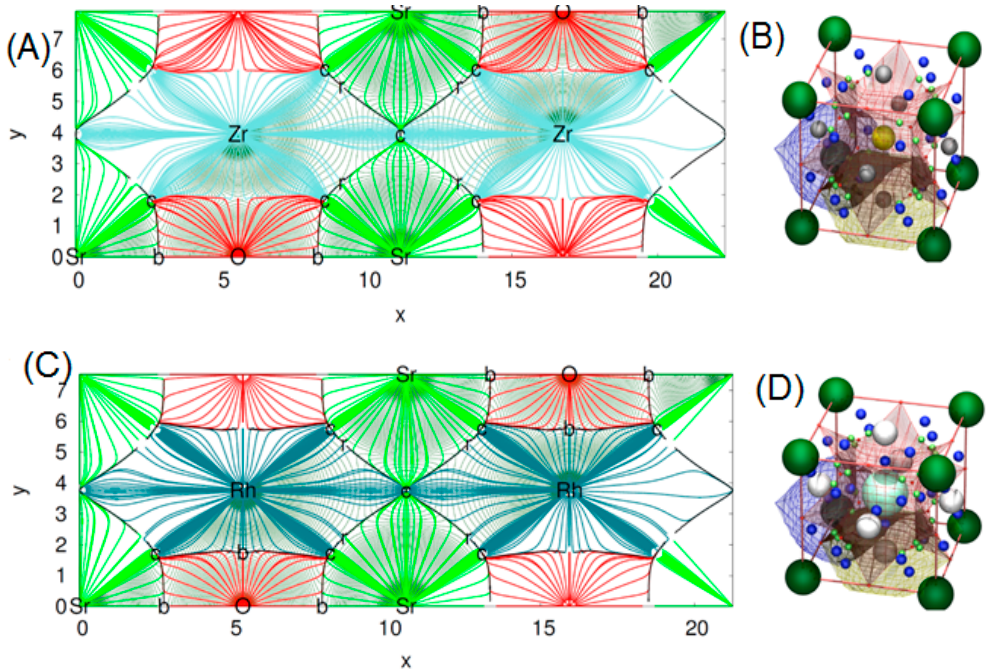
Figure 7. 2D map of topological analysis of electron density of ( A ) SrZrO 3 and ( C ) SrRhO 3 , molecular graph representation of ( B ) SrZrO 3 and ( D ) SrRhO 3 . In colored trajectories traced out by the electron density gradient, vector field (in electron/bohr 3 ) of upper panel: SrZrO 3 and lower panel: SrRhO 3 are at their denser plane. Here, the red, dark blue, light blue and green lines refer respectively to O, Rh, Zr and Sr atomic basins. The set of trajectories that terminates at each bond’s critical point (b) defines an interatomic surface. The set of trajectories that originate at the ring critical (r) point defines the perimeter of the interatomic surface. The gradient paths associated with the negative eigenvalues at the (n) point terminate at this CP and define the zero-flux surfaces that partition the crystal into unique fragments (the atomic basins). On the right of the figures, molecular graph representation: the small red balls placed at the Wyckoff’s 3c are the r CPs. The light green balls the b CPs and the dark blue the c cage CPs.